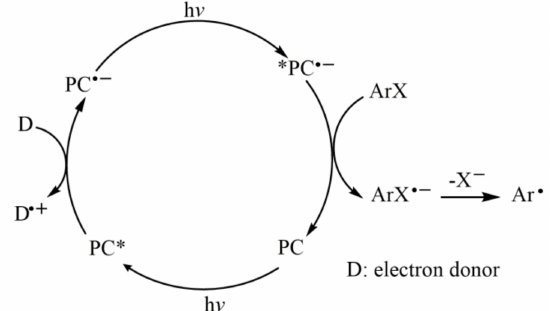
Figure 15. Proposed mechanism of reduction of aryl radicals by consecutive visible-light-induced electron transfer processes.